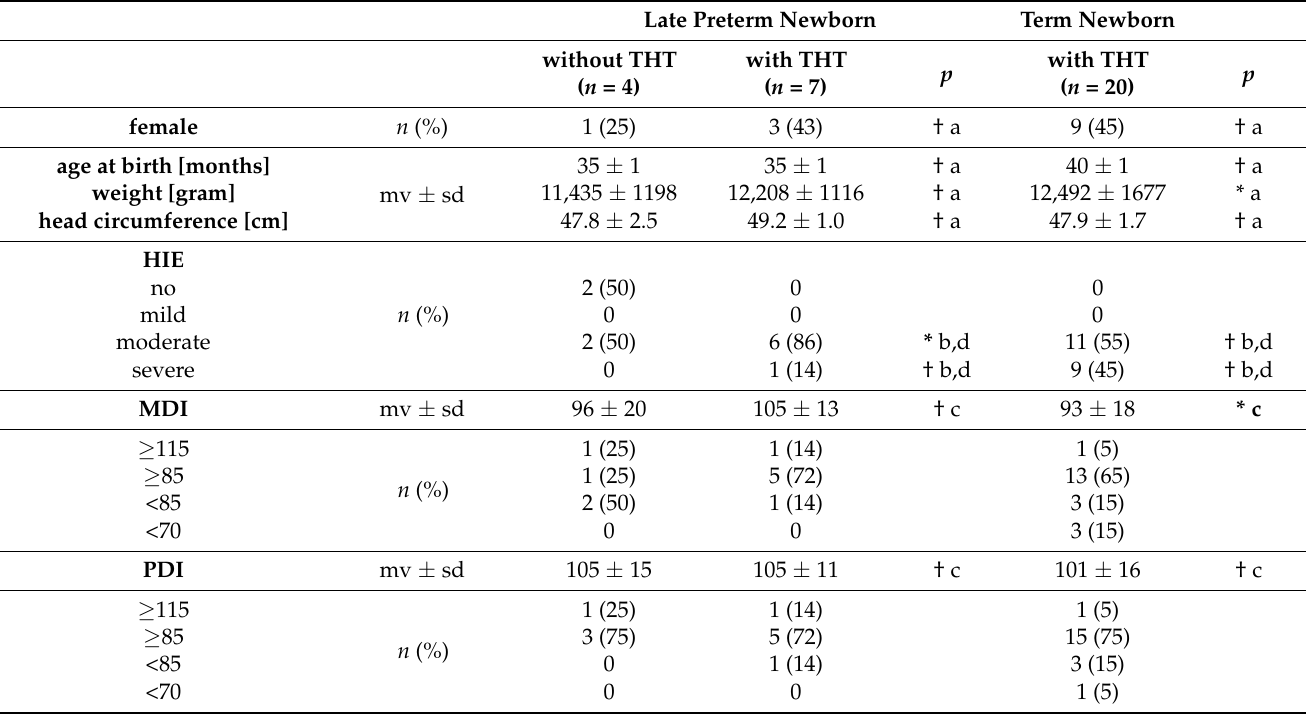
Table 2. Developmental status of late preterm newborns with and without HIE, as well as term newborns with therapeutic hypothermia at the age of (corrected 24)